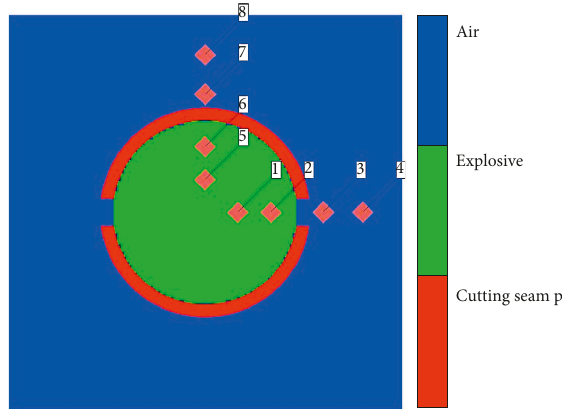
Figure 11: Calculation